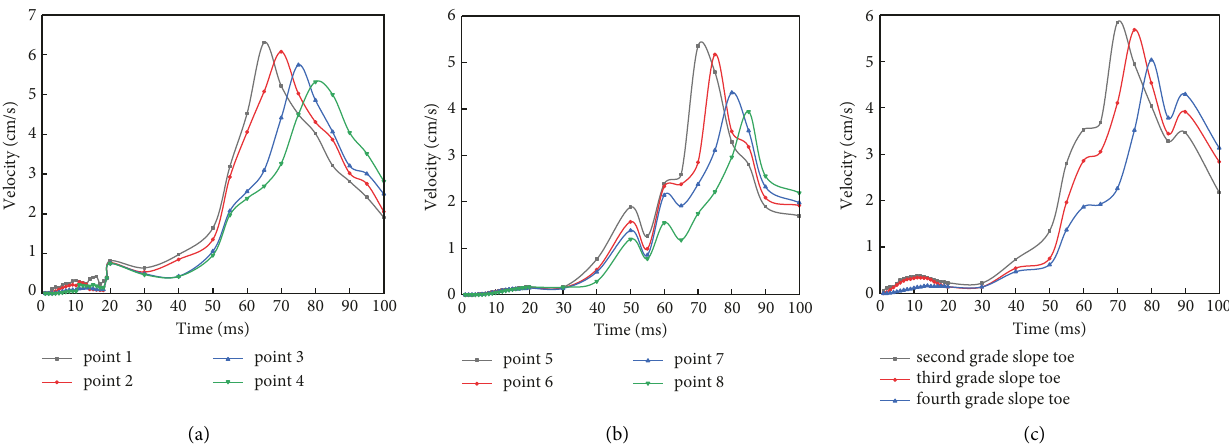
Figure 17: Time-history curve of the vibration velocity of different measurement points at different positions and different times during simultaneous detonation. (a) On the slope toe. (b) On the slope top. (c) On the slope surface.